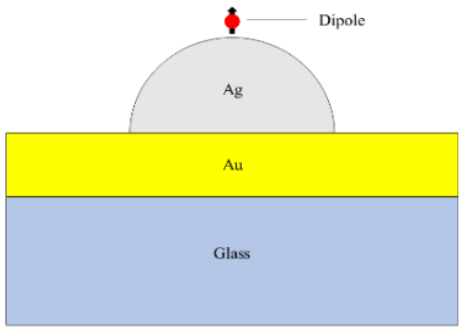
Figure 1. Schematic cross-section of the model under study in this work.